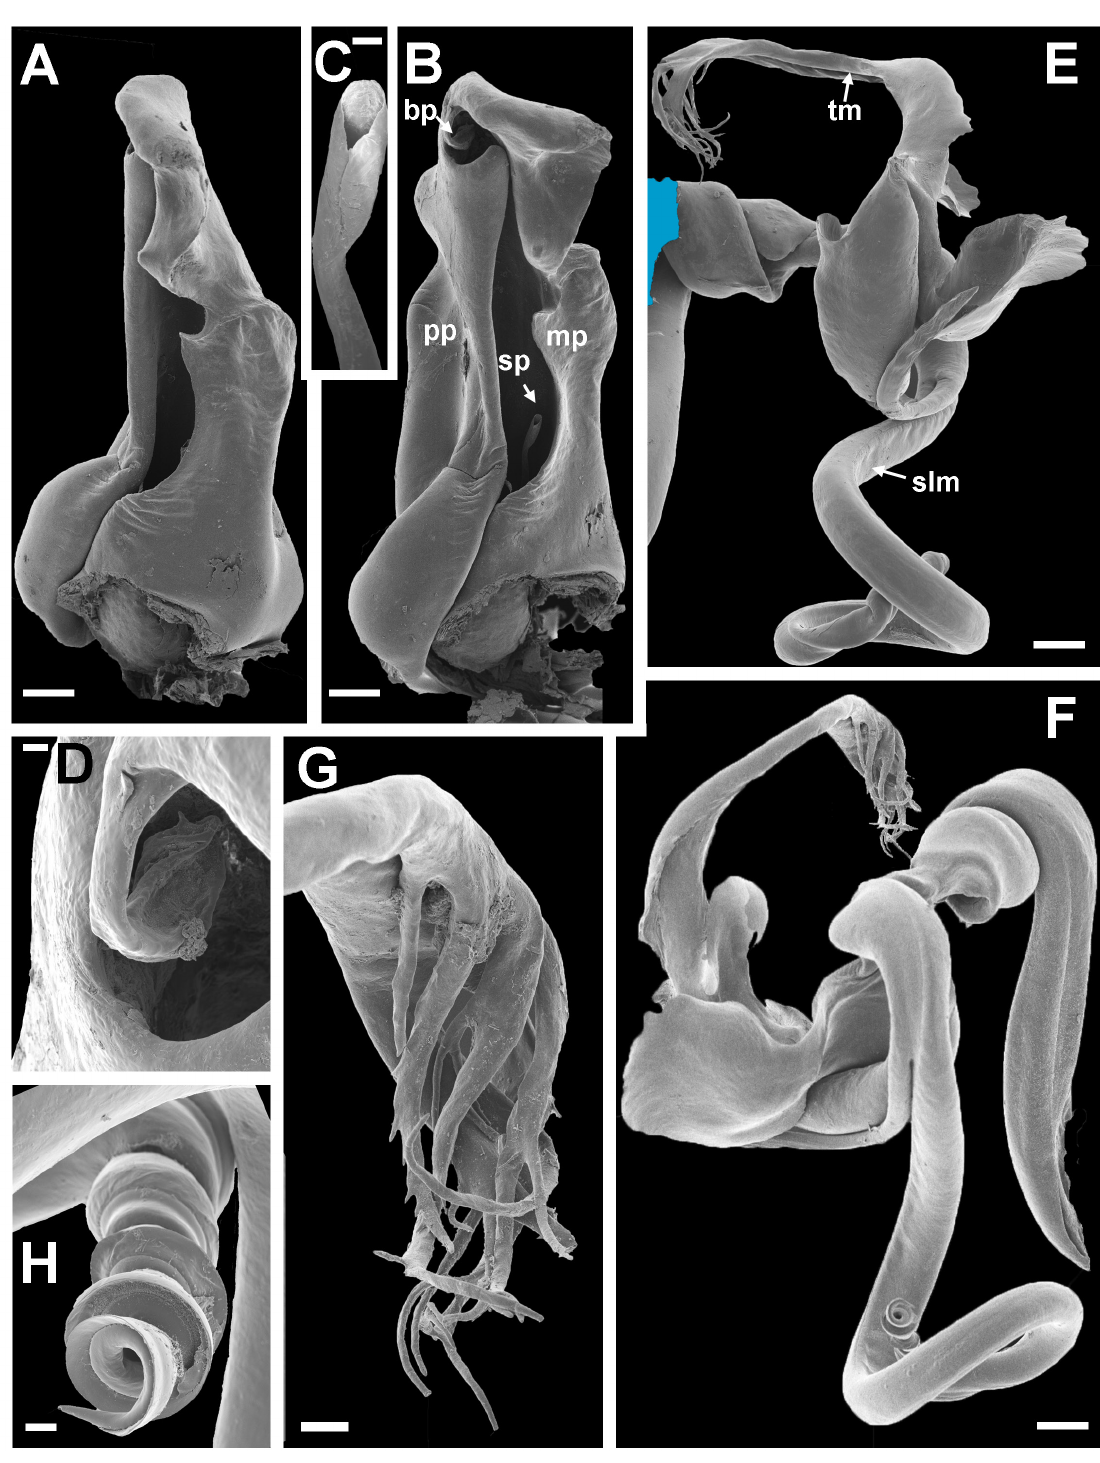
Fig. 5. Helicochetus dimidiatus (Peters, 1855), ♂, from Udzungwa Mts. Left gonopod. A–D . Coxa. A . Mesal view. B . Anterior view. C . Prostatic stylet. D . Apical basad process. E–H . Telopodite. E . Anterior view (the area marked with blue is covered by the mounting tape). F . Posterior view. G . Tip of telomere. H . Tip of solenomere. Abbreviations: bp = apical basad process of coxa; mp = metaplica; pp = proplica; slm = solenomere; sp = prostatic stylet; tm = telomere. Scale bars: A–B, E–F = 0.2 mm; C–D, H = 0.02 mm; G = 0.05